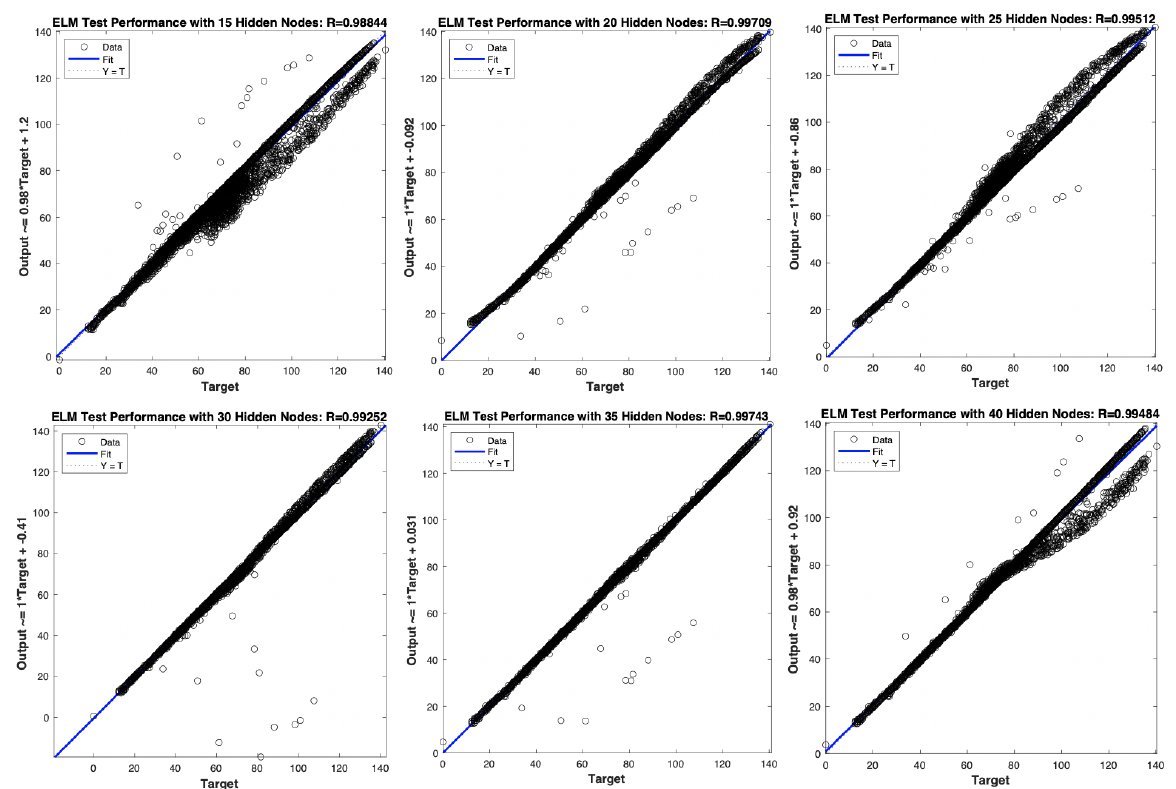
Figure 3. Regression plots of the individual model for the WT#80 in the test step. Values around H = 35 obtain optimal